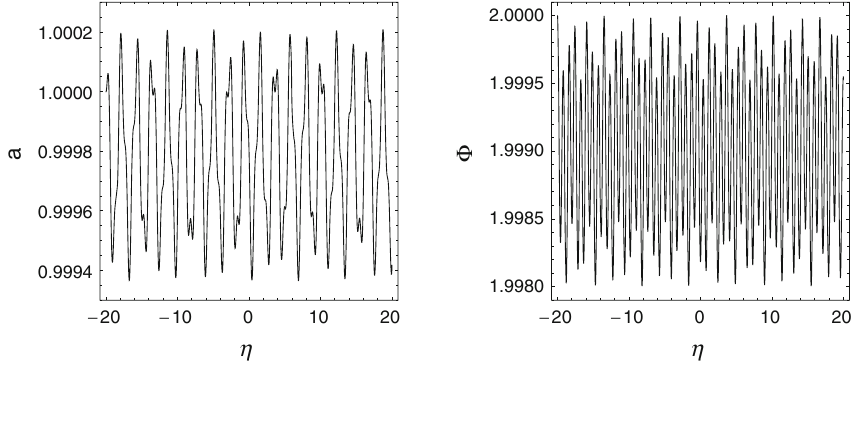
regions show the allowed values for these parameters (for power-law potential) for which the solution is stable against small perturbations. The white regions are not allowed